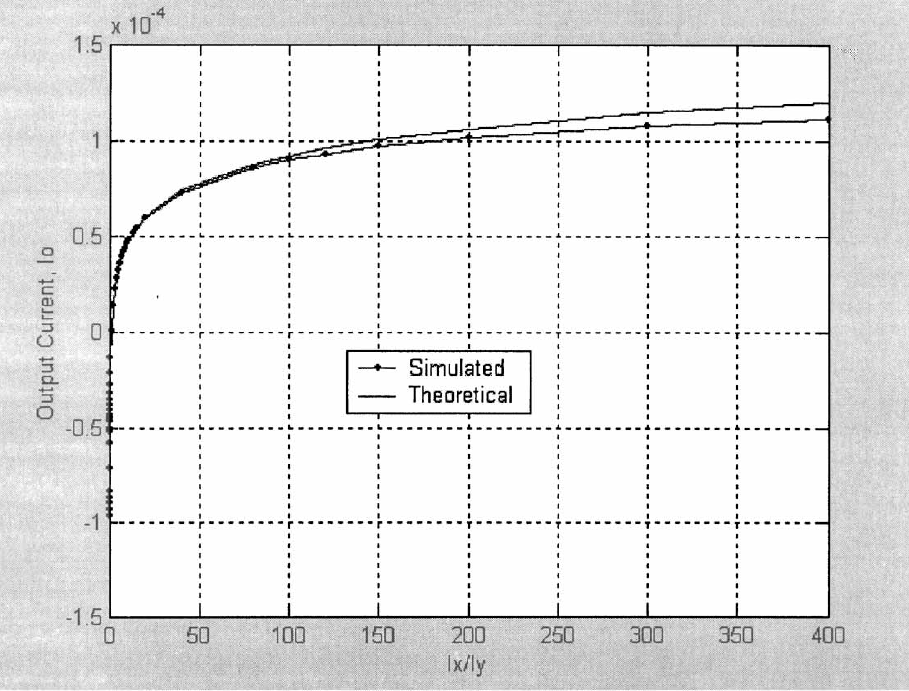
FIGURE 2 Calculated and simulated logarithmic function of Eq.